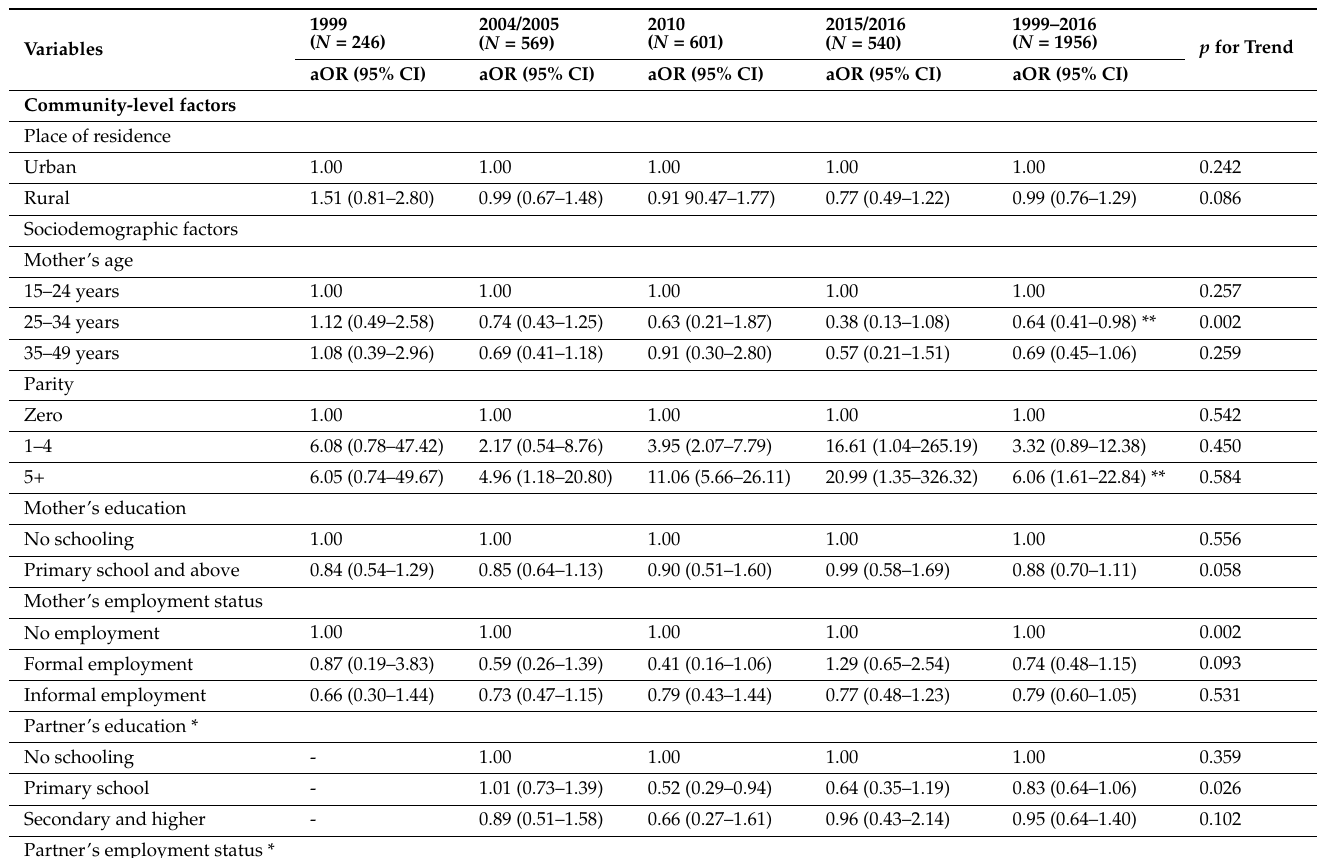
Table 5. Factors associated with unmet need for limiting births in Tanzania, 1999 to